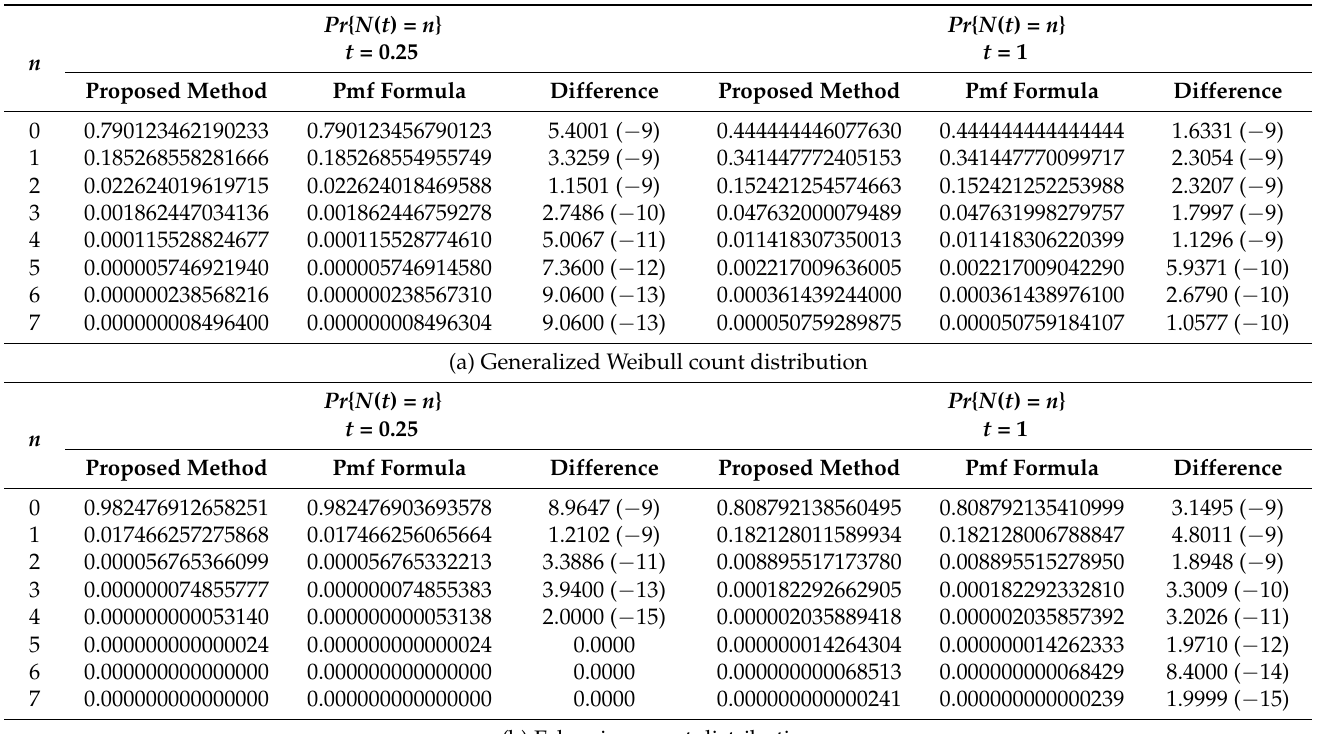
Table 2. Computation of probabilities for ( a ) generalized Weibull, and ( b ) Erlangian count distribu- tions using the proposed method and pmf